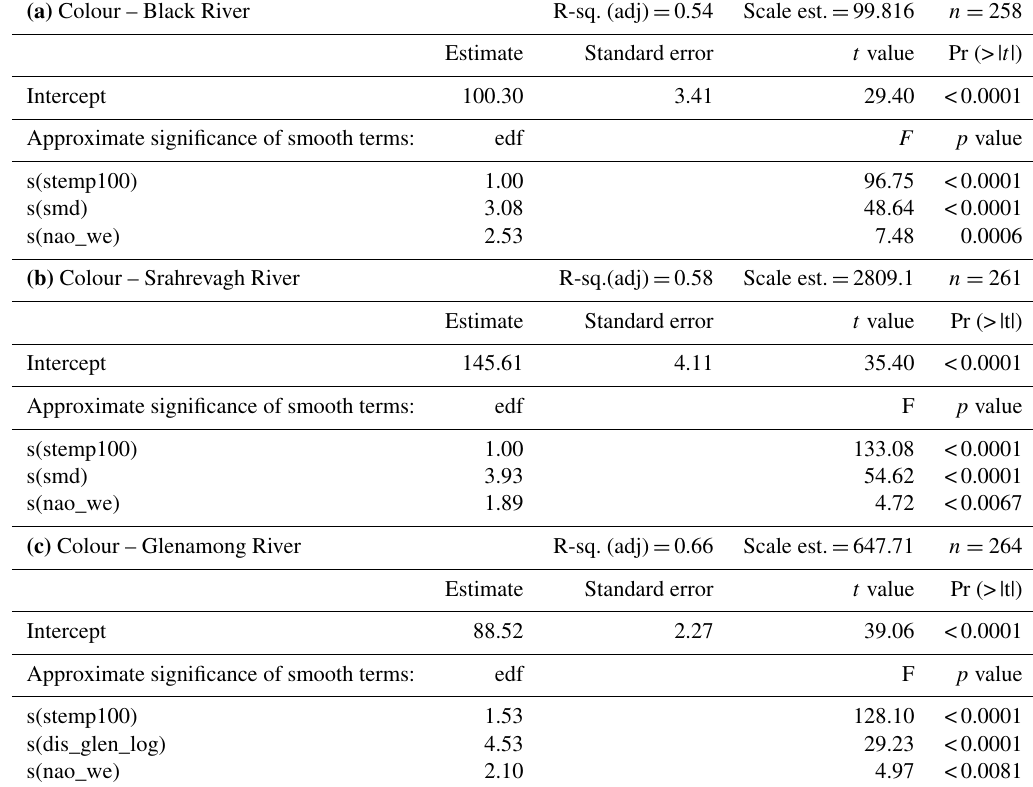
Table 2. Results of generalised additive mixed models (GAMMs) applied to colour in the Black River ( a ), the Srahrevagh River ( b ) and the Glenamong River ( c ) between 2011 and 2016. The (s) refers to the scaled smoother for each explanatory variable. Stemp100 refers to soil temperature at 100cm depth, smd refers to soil moisture deficit, dis_glen_log refers to the log of the discharge of the Glenamong River and nao_we refers to weekly mean values of the NAO index; edf is the estimated degrees of freedom. (a) Colour – Black